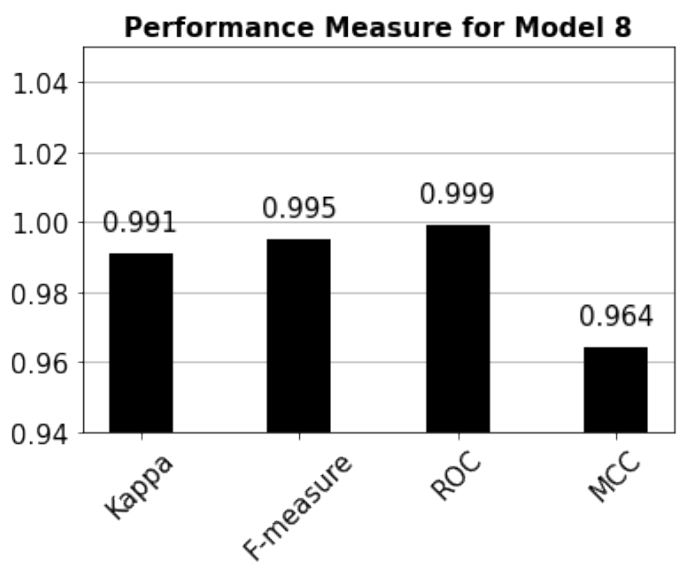
Figure 9. Performance on the fog node (using a model with KNN, NB, and DT as the base classifiers as well as voting as an ensemble